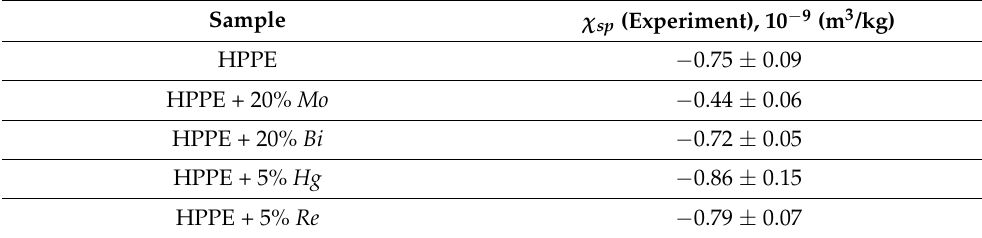
Table 10. Magnetic susceptibility of samples with χ sp <